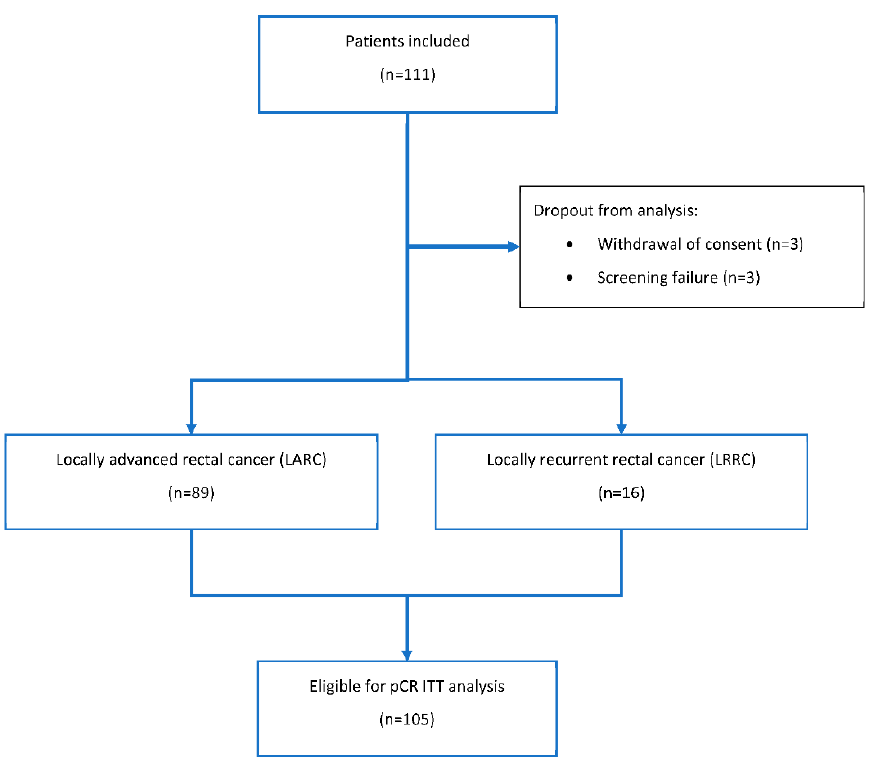
Figure 1. Consort diagram. pCR: pathologically confirmed complete remission. ITT: intention-to treat.